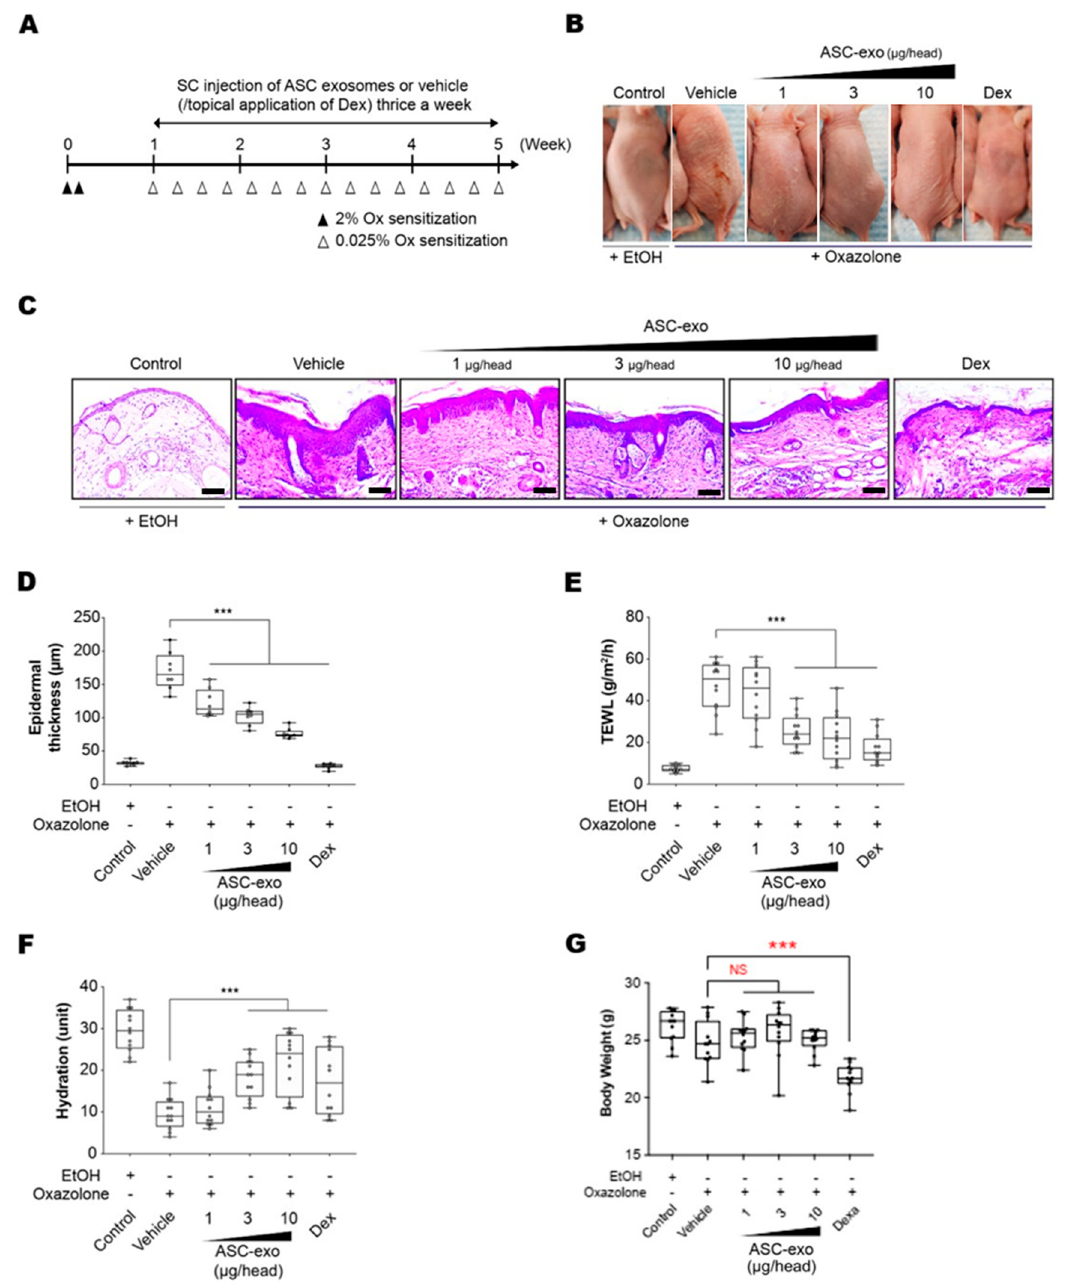
Figure 3. ASC-exosomes improve atopic dermatitis (AD) induced by repeated exposure to Ox. ( A ) Schematic diagram of the study protocol. The first two days 2% Ox was applied, before leaving 5 days for recovery. Dexamethasone was topically applied thrice a week as a positive control. ( B ) Representative dorsal skin photographs of each treatment group showing comparison of AD-like skin lesions ( C ) Representative images of hematoxylin and eosin (H&E)-stained epidermal histological sections from dorsal skin of mice from di ff erent treatment groups showing thickness of epidermis. The sections were visualized with a 20x magnification. Box and whisker plot of ( D ) epidermal thickness, ( E ) TEWL, and ( F ) stratum corneum (SC) hydration. The median and the 5th and 96th percentile are shown. Error bars depict the SEM. *** p < 0.001 vs. vehicle. ( G ) E ff ects of ASC-exosomes and dexamethasone on body weight changes. Note that the treatment of dexamethasone induced significant body weight loss. n = 12 per group. *** p < 0.001 determined by one-way ANOVA.